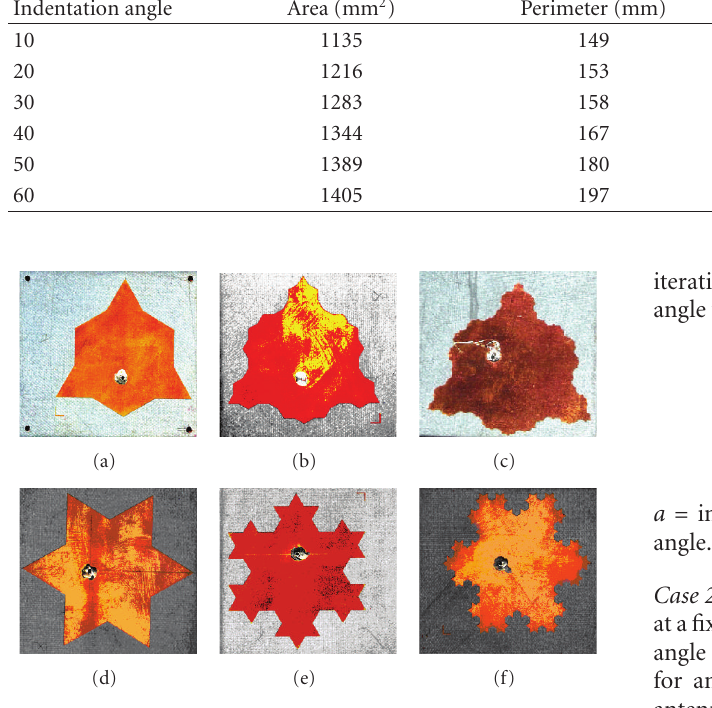
Figure 7: Fabricated fractal boundary patch antennas with inden- tation angles of 30 ◦ and 60 ◦ : 1st iteration, 2nd iteration, and 3rd